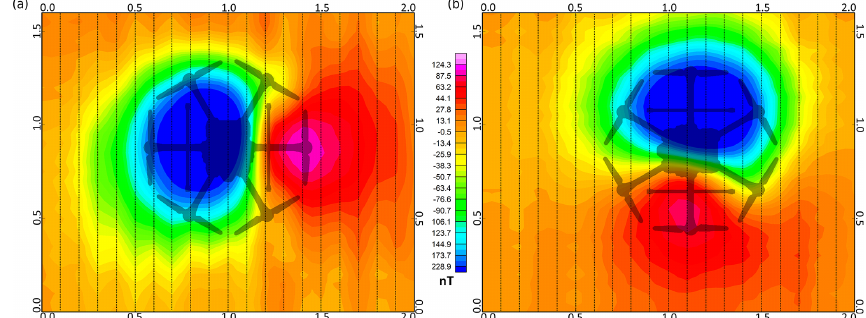
Figure 7. Interference map of the HRH facing magnetic north (a) and east (b) . Border units are in